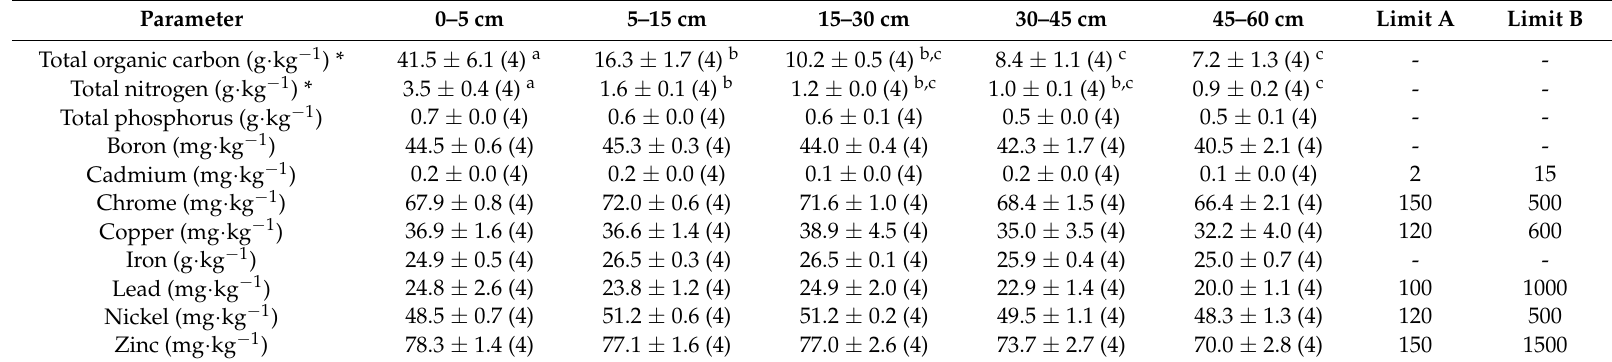
Table 6. Concentrations of nutrients or heavy metals at different depths of the CW soil in 2017 (values are displayed as: mean ± std error and number of samples in